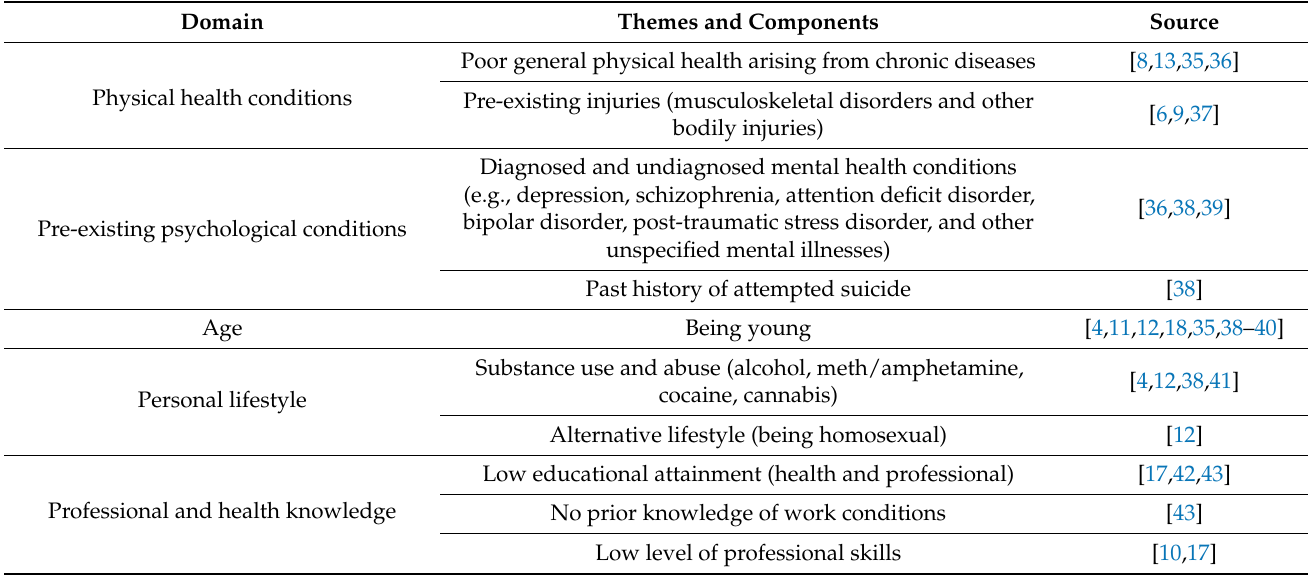
Table 2. Young construction workers’ personal psychosocial risk factors.